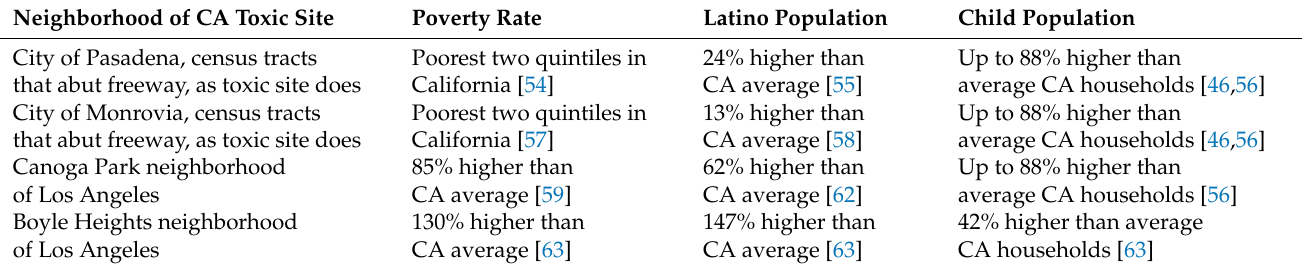
Table 9. Toxic-site demographic and environmental-justice